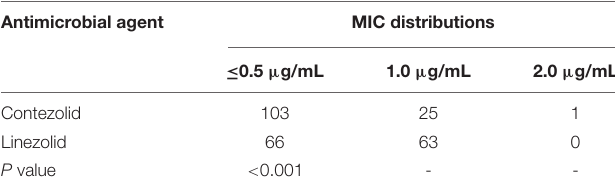
TABLE 3 | MIC distributions of two antimicrobial agents against VRE strains.